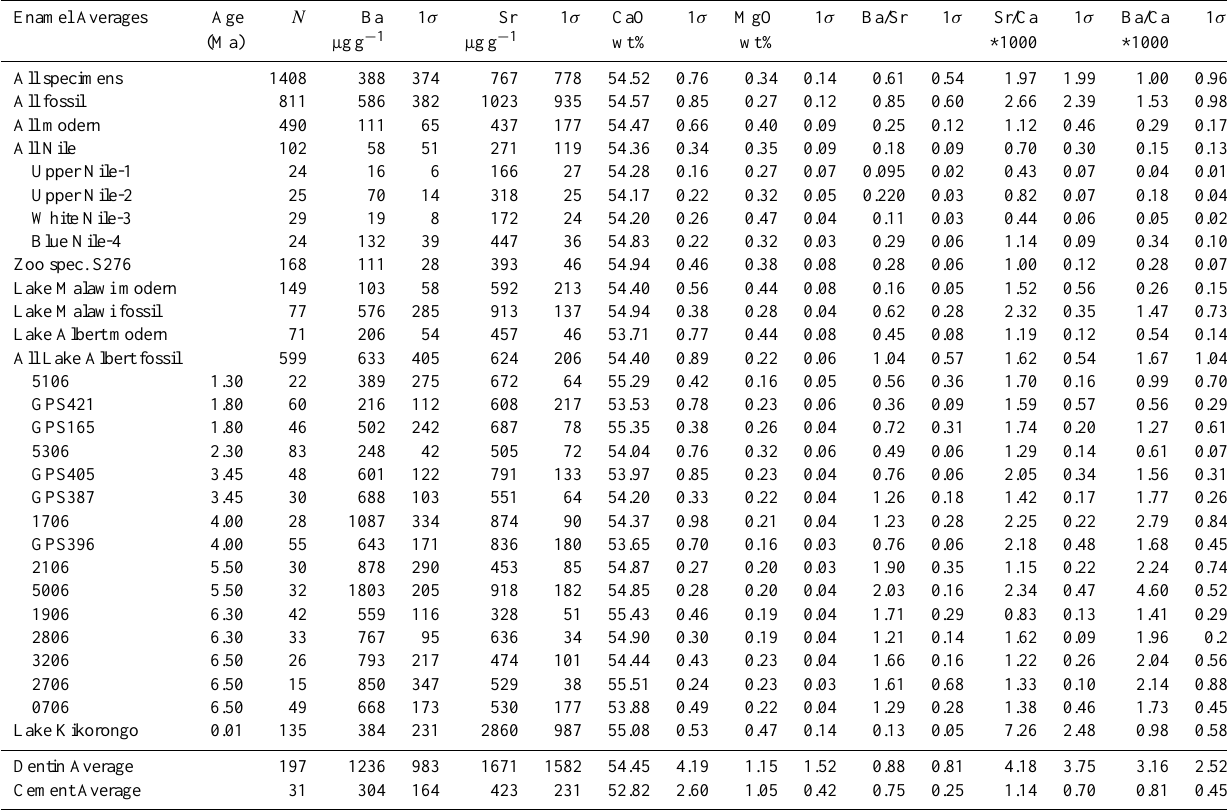
Table 1. Average concentrations of alkaline earth elements in modern and fossil hippopotamid enamel, dentin and cement. Enamel Averages All